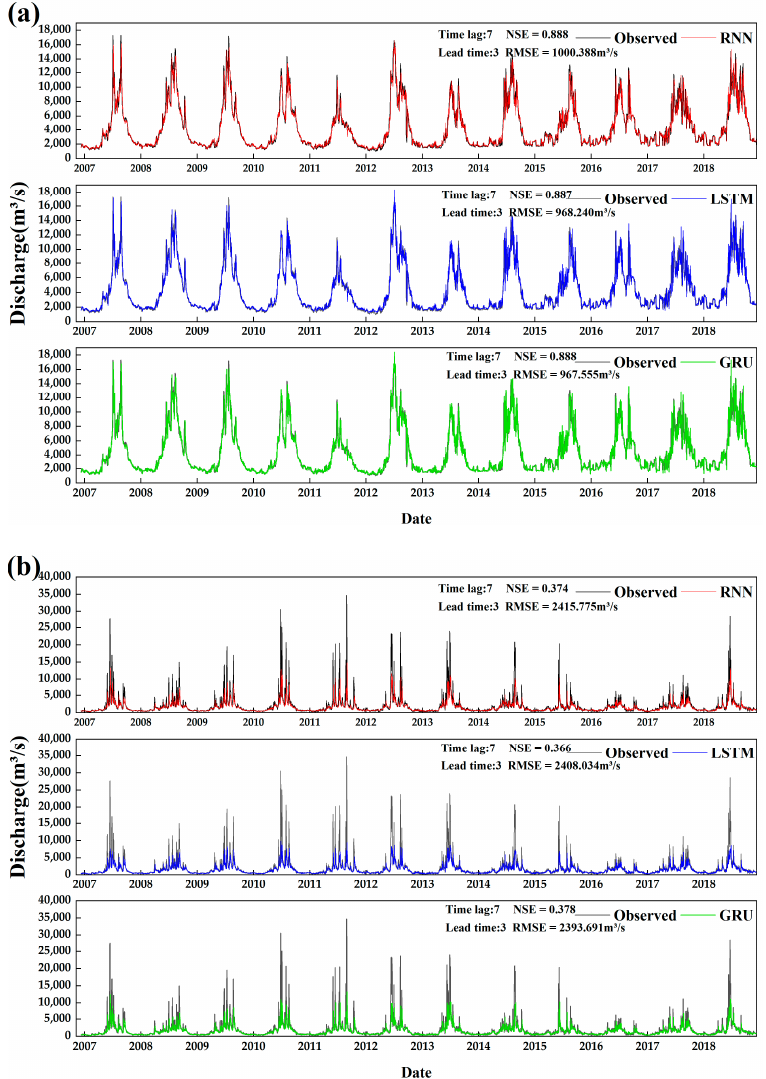
Figure 7. Observed and predicted discharge from RNN, LSTM, and GRU models at optimal time lag and lead time at daily scale in ( a ) Pingshan and ( b ) Beibei.